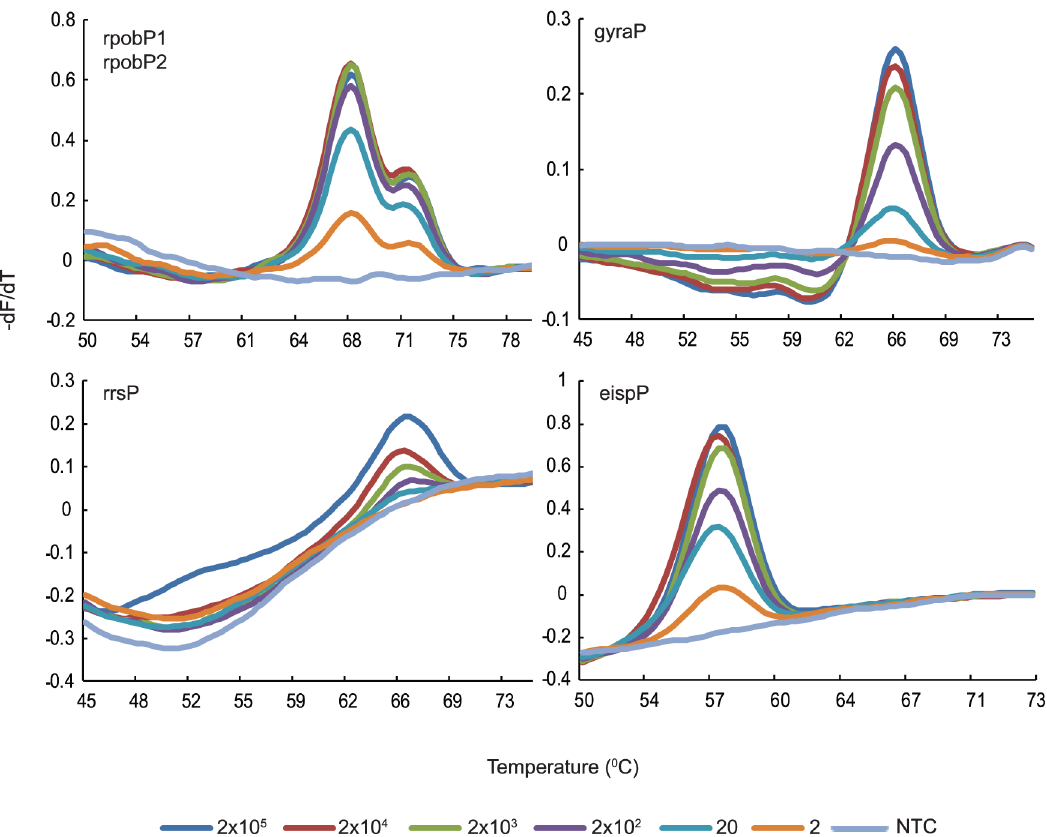
Fig 2. Analytical sensitivity of the DLP assays. Melting temperature first derivative peak profiles for all the targets for the DLP probes on serial dilutions of M . tuberculosis H37Rv genomic DNA. Input DNA amount is indicated as genome